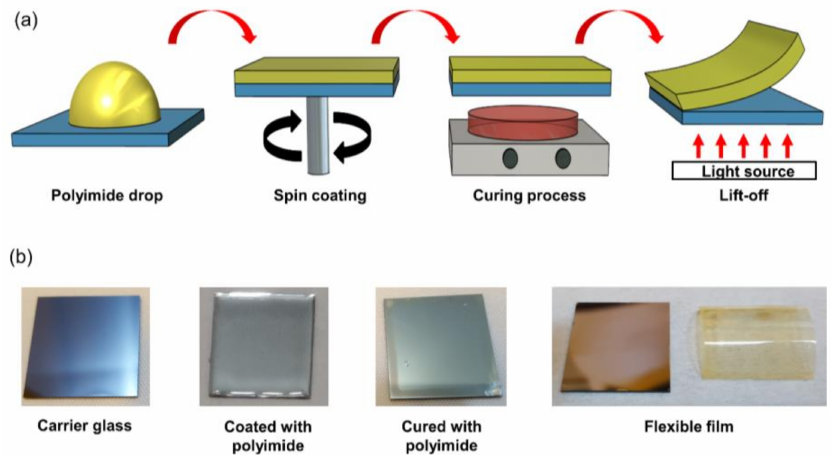
Figure 2. ( a ) A schematic description of fabricate flexible film; ( b ) an image of fabricated polyimide (PI) film.